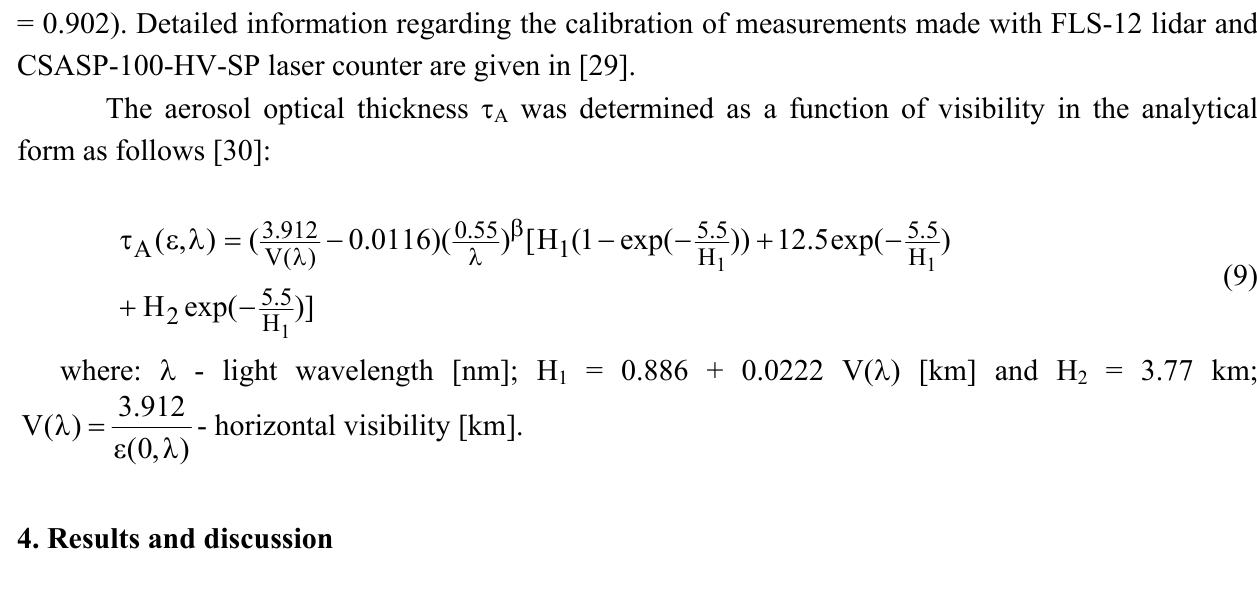
Figure 2. Aerosol concentrations obtained from simultaneous measurements with FLS-12 lidar and CSASP-100-HV-SP laser